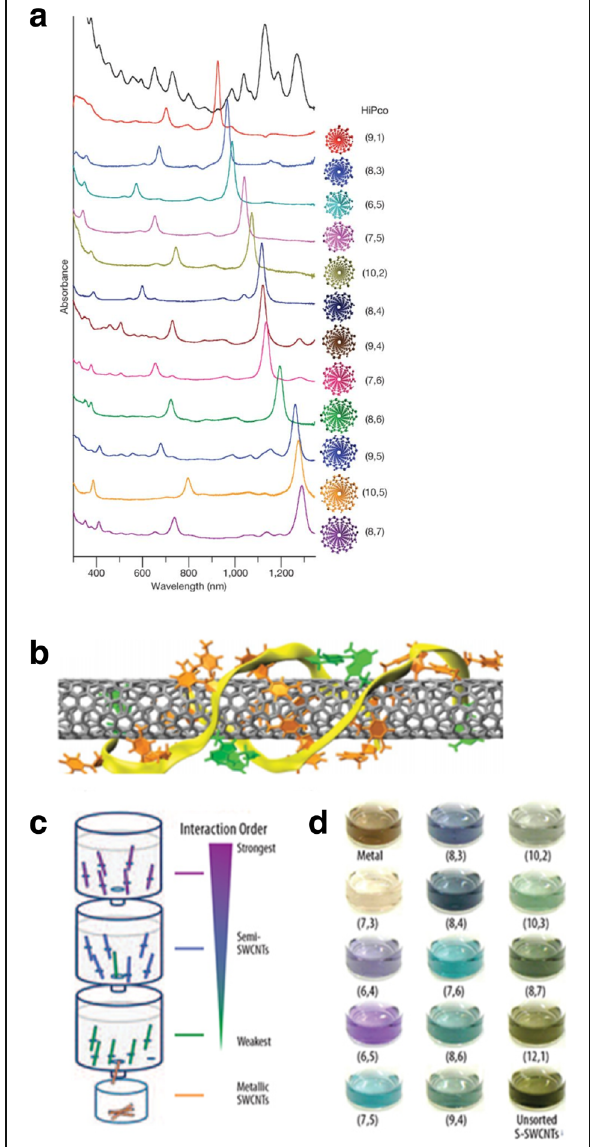
Fig. 22 Purification of CNTs with defined helicity with the aid of specific DNA sequences using IEX. a Absorption spectra of twelve purified semiconducting CNT species along with their ( n, m ) structural